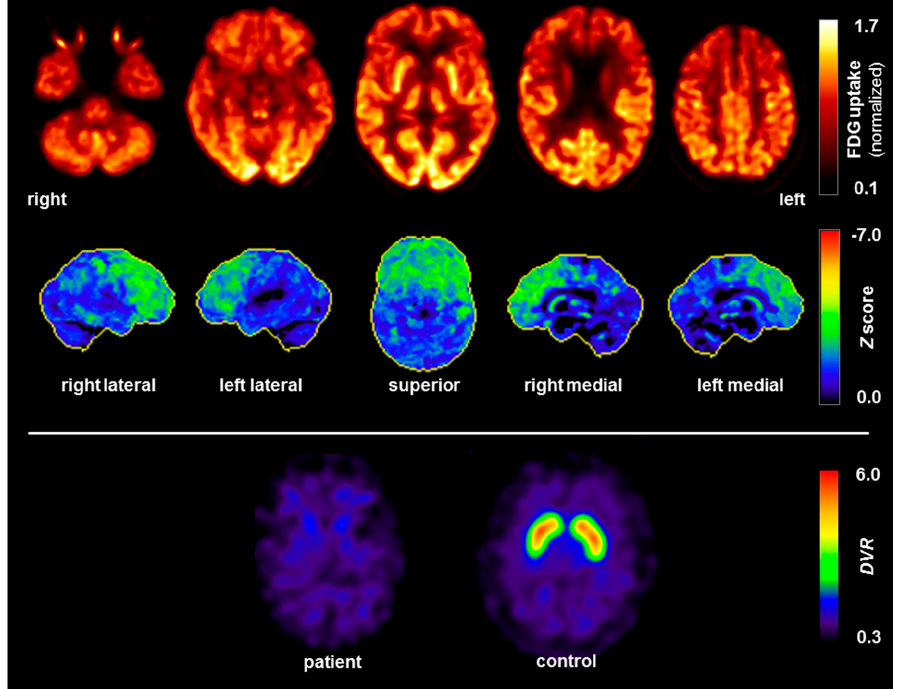
Figure 3. [ 18 F]fluorodeoxyglucose positron emission tomography (FDG PET; upper panel) and [ 123 I]FPCIT single-photon emission computed tomography (FPCIT SPECT; lower panel). The